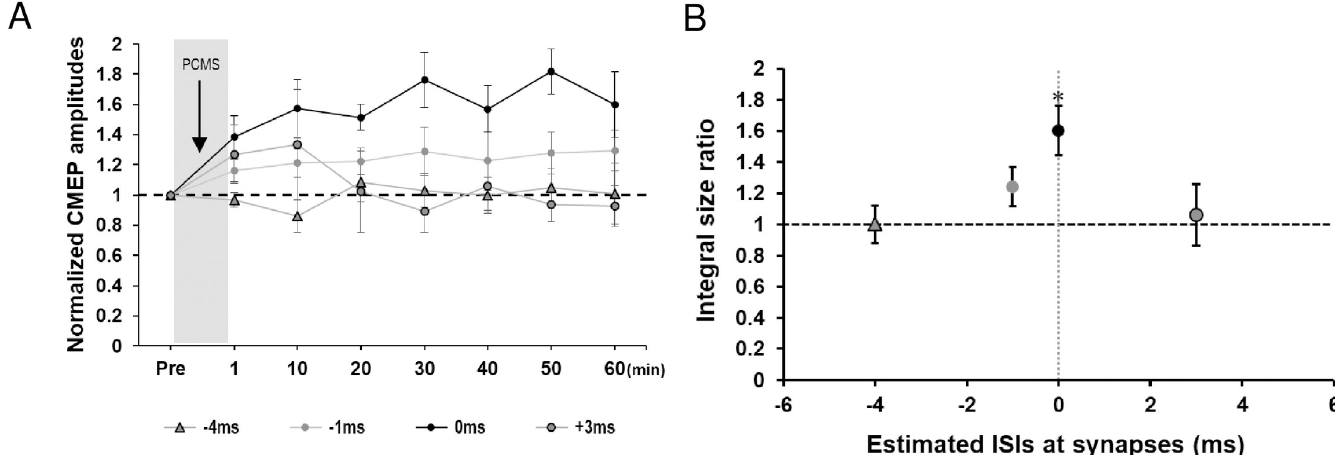
Fig 2. CMEP amplitudes after PCMS in Preliminary experiment. (A) Time courses of the average CMEP size ratio from 10 to 60 min after PCMS using a supramaximal PNS at ISIs of -4, -1, 0, and +3 ms. CMEP amplitude increased after PCMS with an ISI of 0 ms. (B) The integral size ratio (ISR) at various estimated ISIs at motoneurons (TMS-PNS interval). The ISR increased significantly at the ISI of 0 ms. � P < 0.05. All data are mean and standard-error values.